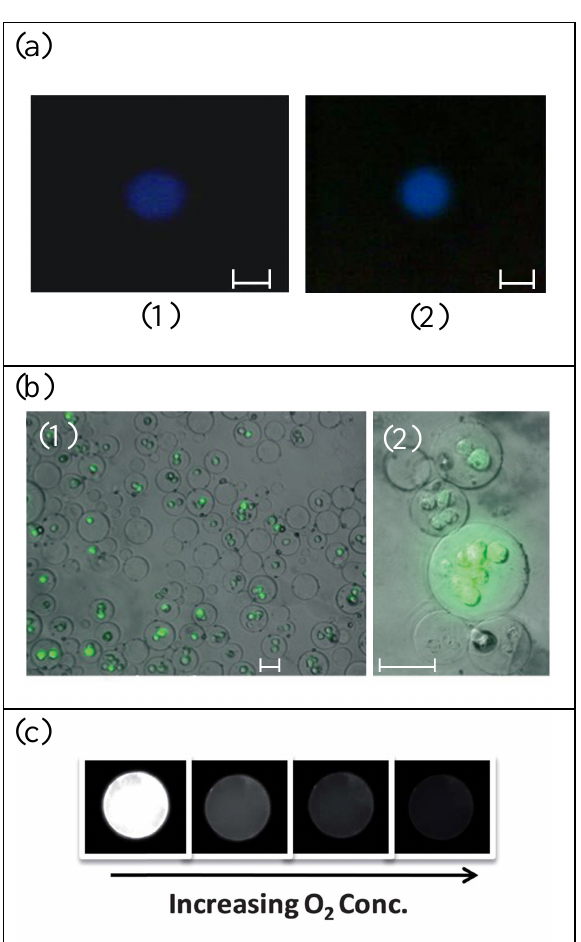
Figure 4. Illustration of biological functionalities of RBC templates. ( a ) chemiluminescence experi- ments showing the oxygen carrying capacity: (1) PLGA RBC template (2) mouse blood [34], the scale bar is 0.5 cm; ( b ) MDA-MB231 cells encapsulated in PEG microparticles: (1) at day 0 and (2) at day 13 [71], green fluorescence represents live cells, the scale bar is 50 µ m; ( c ) phosphorescence intensity of a PtTFPP-bearing PDMS microbead (150 mm diameter) at various oxygen levels [72]. Reproduced from Ref. [34,71,72] with permission from National Academy of Sciences, and The Royal Society of